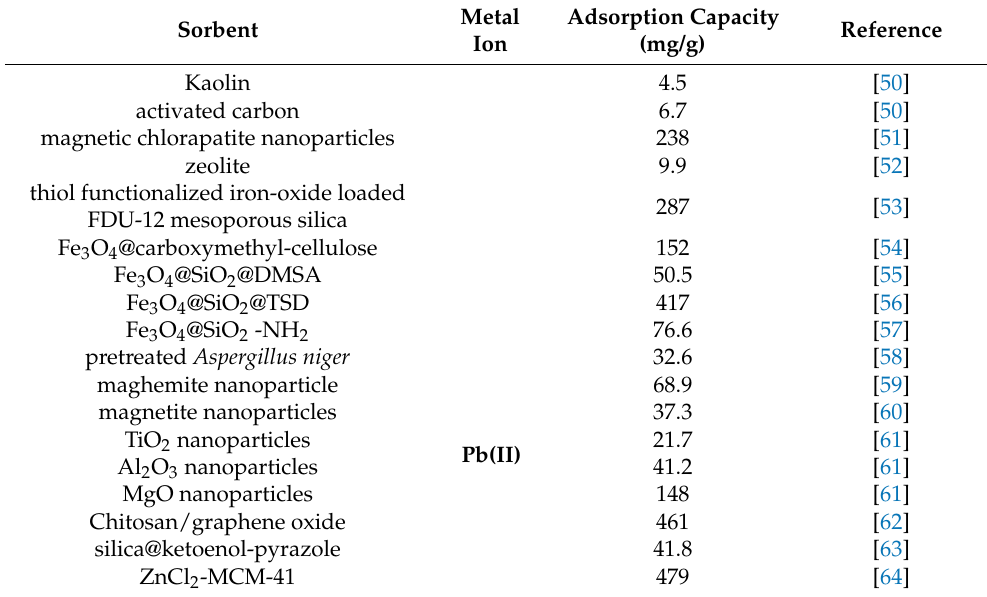
Table 3. Comparison of the Me(II) adsorption capacity of the prepared mesoporous silica samples to other adsorbent